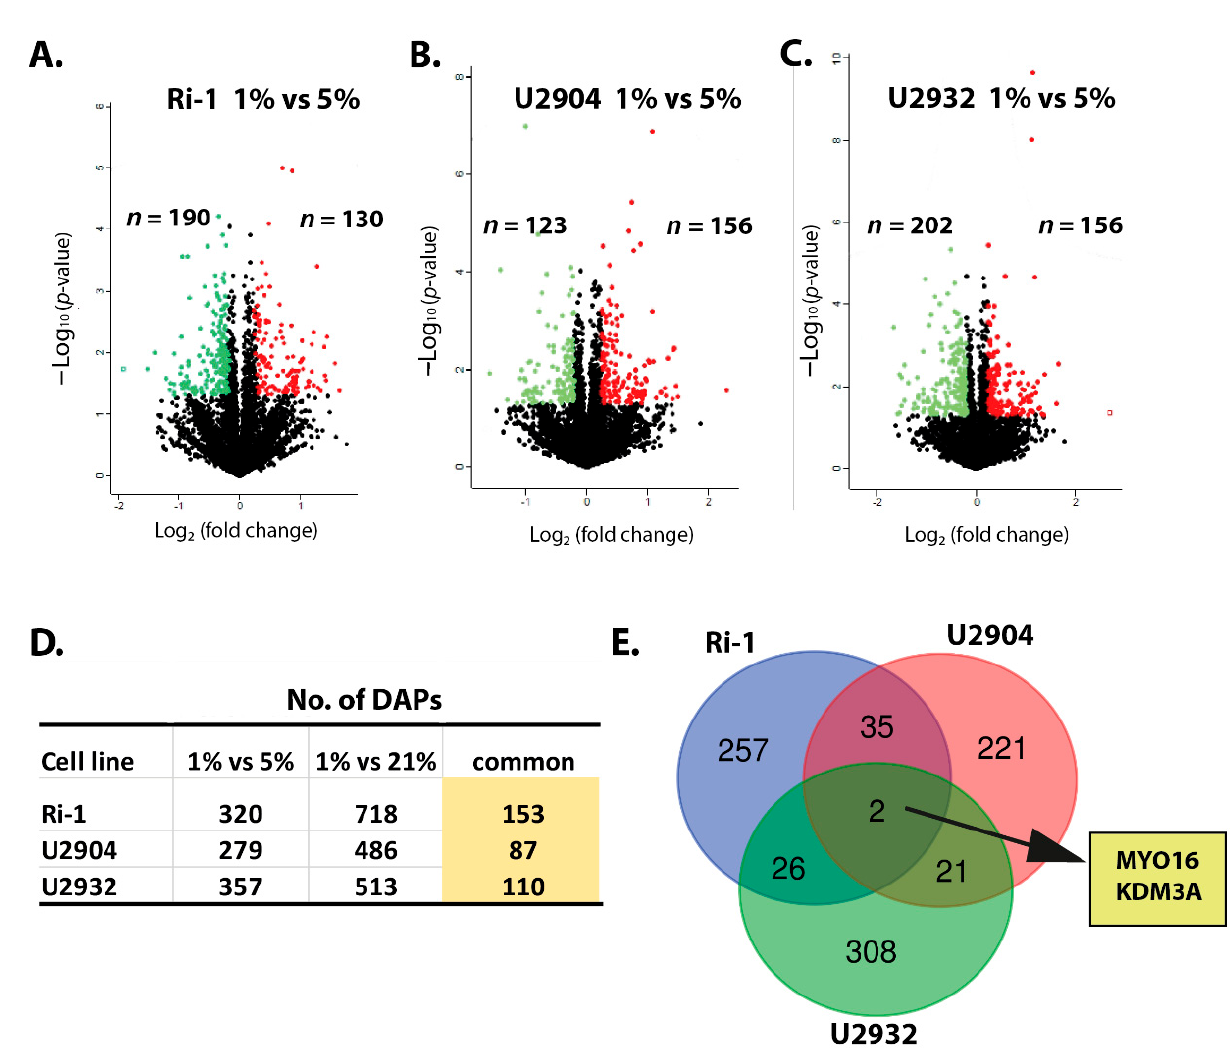
Figure 4. Volcano plots of data from label-free quantification of differentially abundant proteins (DAPs) in hypoxic (1% of O 2 ) ( A ) Ri-1 cells, ( B ) U2904 cells, and ( C ) U2932 cells when compared to physioxia (5% of O 2 ). Red dots represent upregulated proteins with fold change ≥ 1.5, while green dots represent downregulated proteins with fold change ≤ − 1.5, p -value cutoff < 0.05. Generated in Perseus software. The complete list of DAPs with all details is placed in Table S2. ( D ) Venn diagram showing number of DAPs overlapping among Ri-1, U2904, and U2932 cell lines in hypoxia when analyzed versus physioxia. The list of shared proteins is provided in Table S3. ( E ) The table showing the number of DAPs commonly identified in each cell line when (i) hypoxia compared to physioxia, and (ii) hypoxia compared to normoxia.